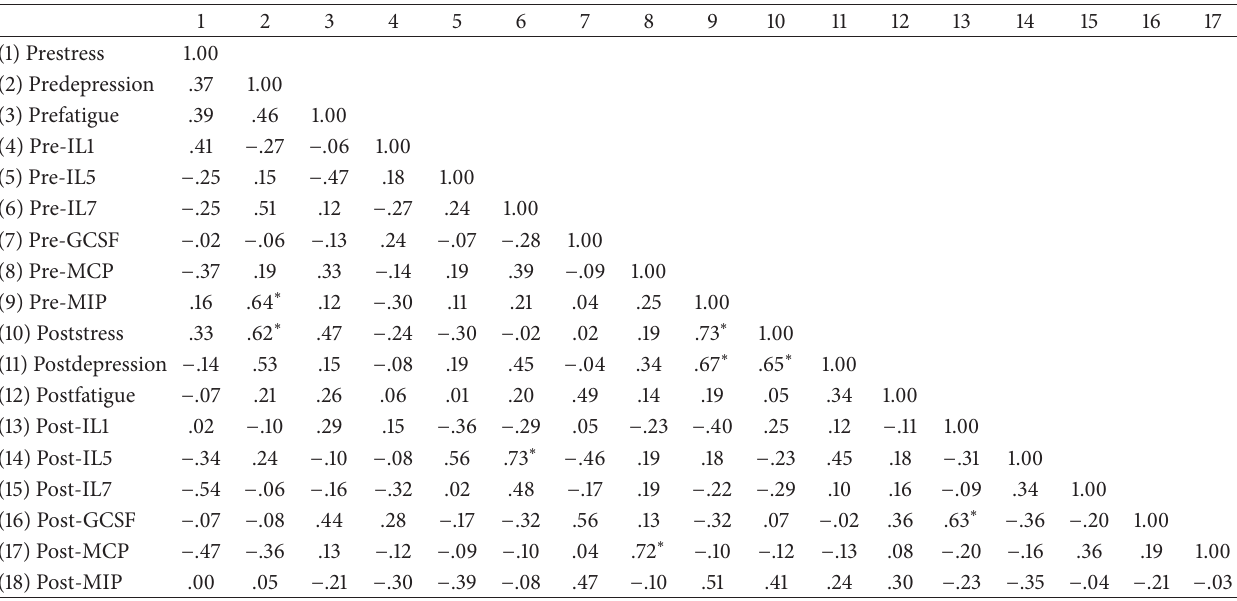
Table 2: Correlations between measured variables and cytokines in late pregnancy and early